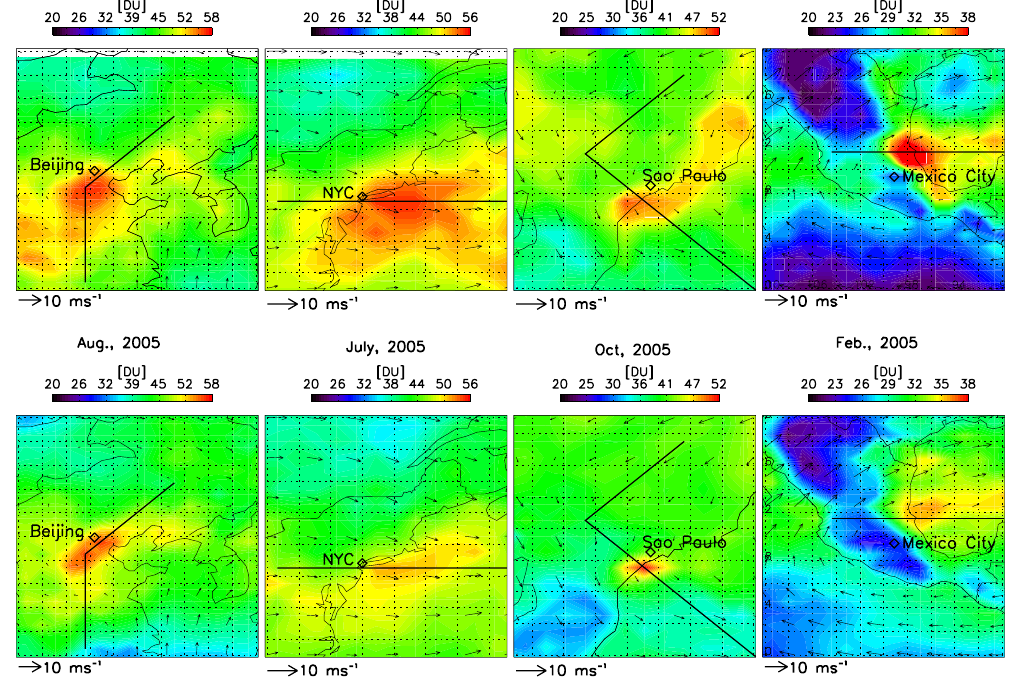
Fig. 1. Examples of urban scale signatures of tropospheric ozone pollution in monthly mean TOR (upper panels) and TCO data (lower panels) for Beijing (August 2005), New York (July 2005), Sao Paulo (October 2005) and Mexico City (February 2005). Note that the upper limits of the color scales have been changed for each city to optimize the detection of the individual plumes because of different pollution levels in various cities. The monthly mean winds (at 850hPa for Beijing, New York, Sao Paulo and at 700hPa for Mexico City) are from the NCEP reanalyses. The black lines indicate the grid cells along which the upstream/downstream TOR/TCO values were compared in Fig. 2.